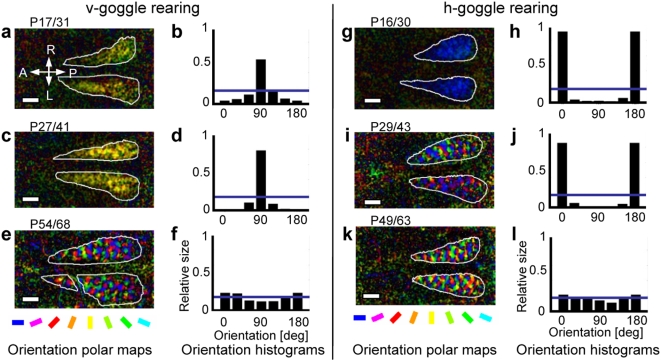
Orientation selectivity in kittens continuously exposed to vertical- or horizontal orientation for 2 weeks.Data obtained by starting/ending GR at the indicated postnatal days are illustrated similarly to Fig. 1a–f.